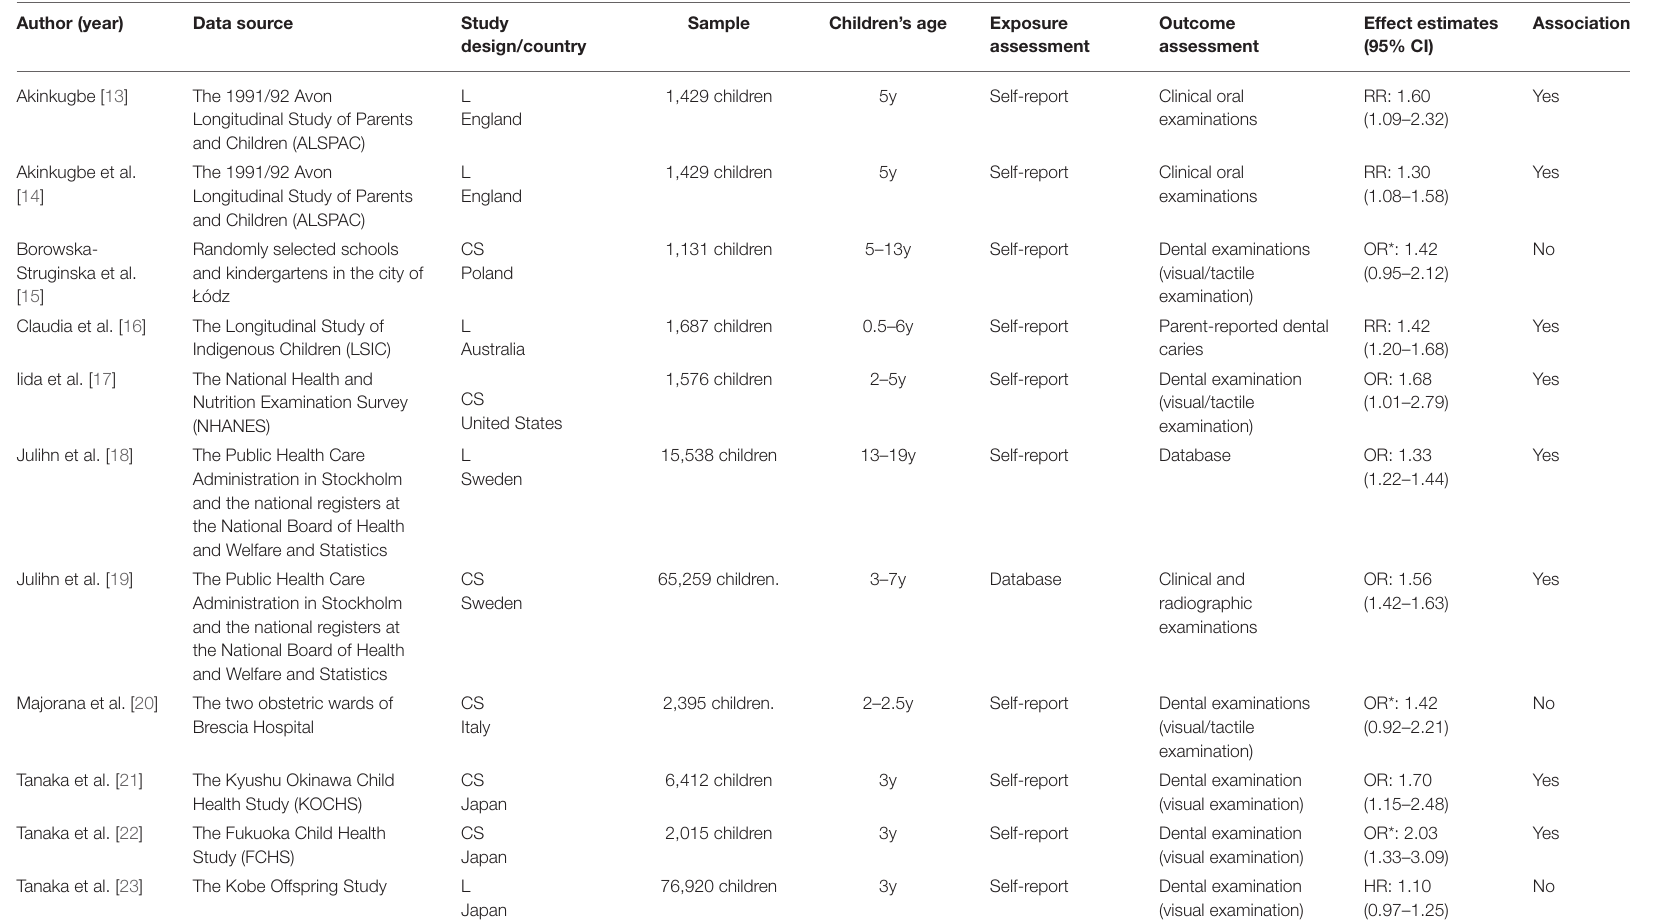
TABLE 1 | Characteristics of the included